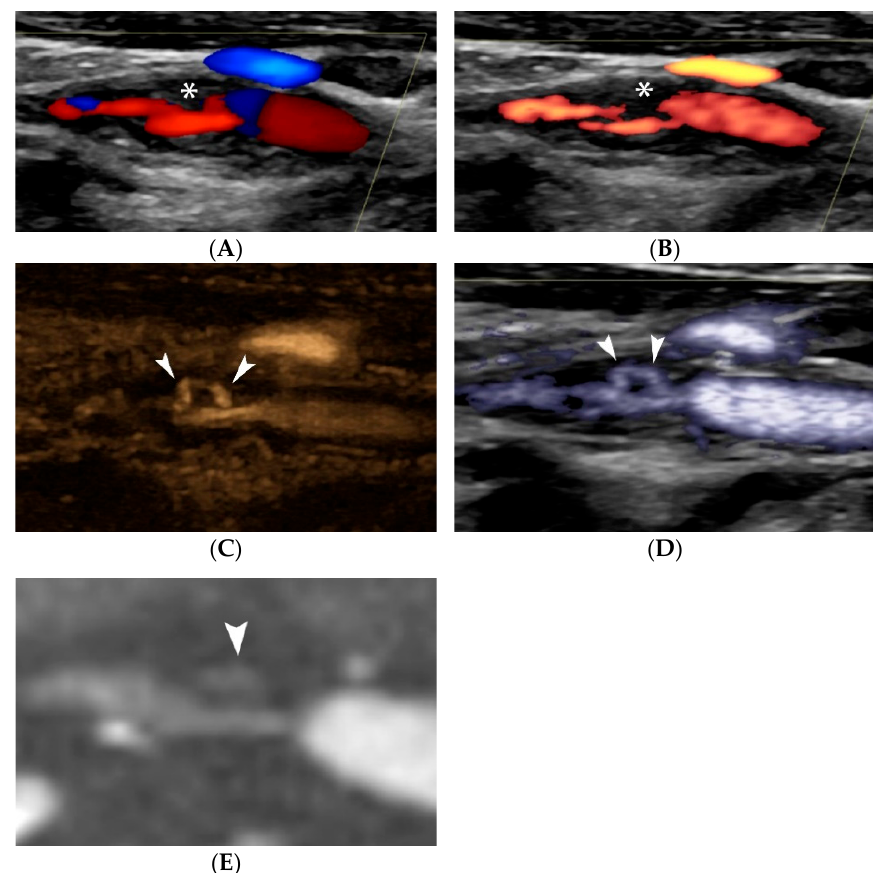
Figure 6. “Handle-shaped” ulceration visualization on Doppler and non-Doppler techniques. Colour Doppler image ( A ) showing a moderately stenotic internal carotid artery plaque with irregular surface (asterisk). Power Doppler technique ( B ) confirming the findings but visualizing more pronounced irregularity (asterisk). B-Flow technique with ( C ) and without static tissue suppression ( D ) show that there is actually a tunnel-like ulceration (arrowheads), also partially identified on CTA ( E ) as an area of enhancement (arrowhead) inside the plaque. Note the blurred appearance of ulceration on CTA due to the lower spatial resolution of the technique as compared with ultrasound, which offers excellent spatial resolution in the field-of-view, particular in the near field.